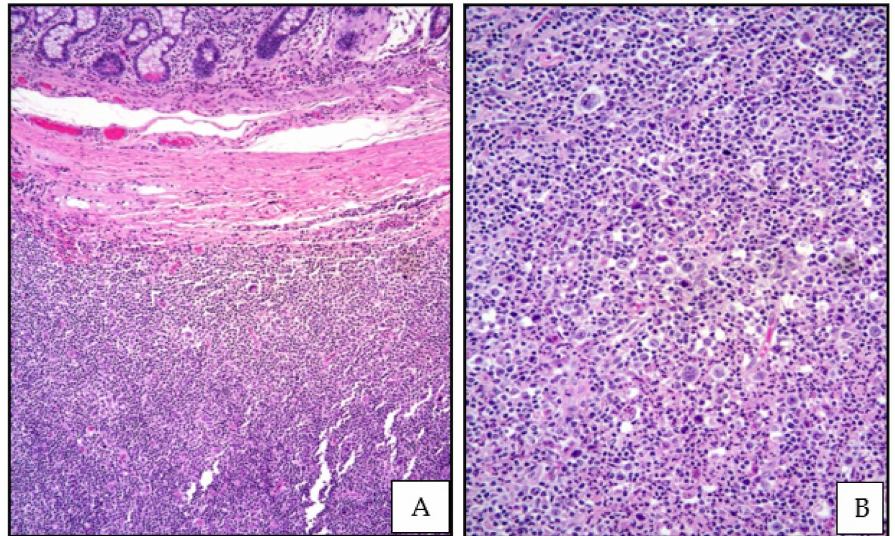
Figure 3. ( A ) cHL: medium power view showing a dense lymphoid infiltrate involving the small bowel wall (Hematoxylin and eosin, magnification 100 × , original image from Prof S.A.); ( B ) cHL: high power of the polymorphic lymphoid infiltrate containing large-sized cells with Hodgkin features (Hematoxylin and eosin, magnification 200 × ; original image from Prof